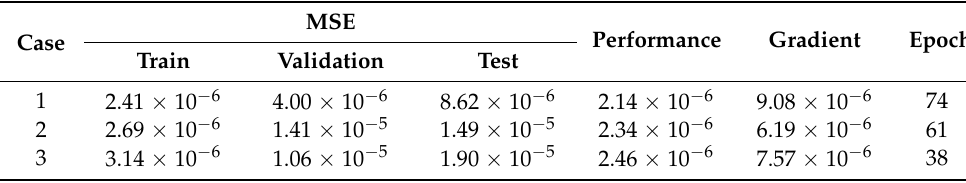
Table 2. MSE measures using the RB-SCGDNN scheme for the nonlinear MTS.